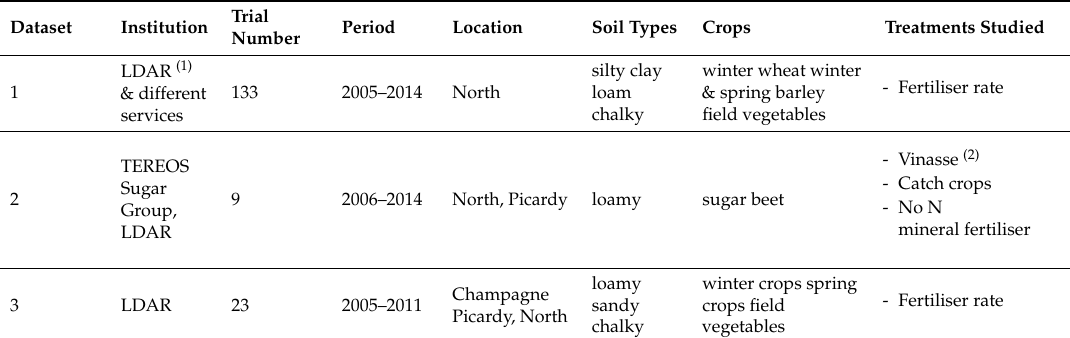
Table 2. Characteristics of the datasets used to test AzoFert ®